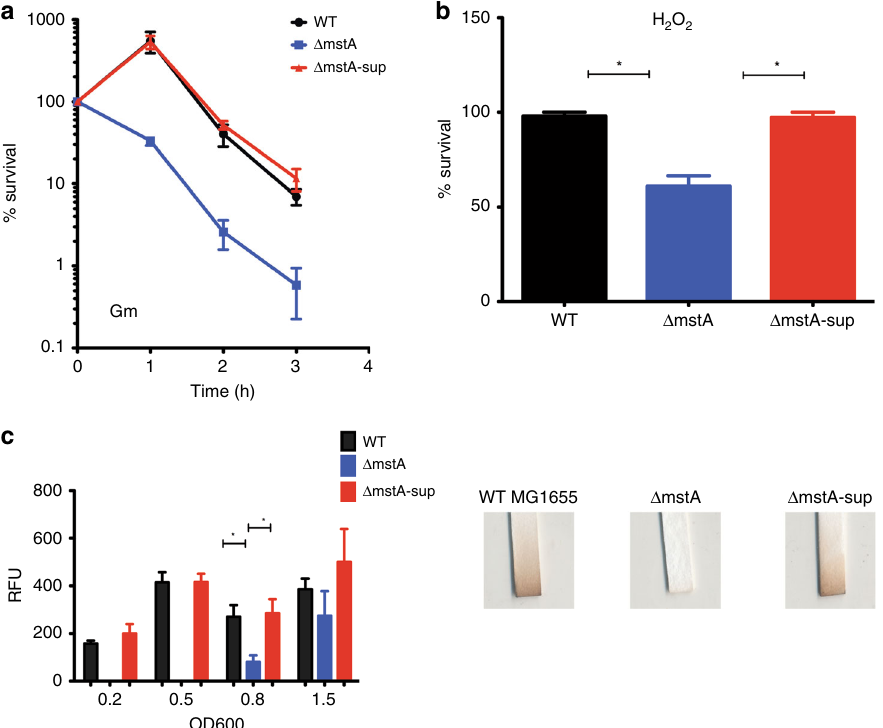
Fig. 1 E. coli MG1655 lacking 3MSTA acquires phenotypic suppression and has increased H 2 S levels and tolerance to Gm and H 2 O 2 . a Δ mstA-sup has increased survival rate compared with Δ mstA when treated with 2 µ g ml − 1 gentamicin in a time-kill assay. Values correspond to colony-forming units (c.f.u). b Δ mstA-sup also has increased tolerance after exposure to 5 mM H 2 O 2 for 30 min. c H 2 S production as measured with fl uorescent probe, WSP5. Relative fl uorescent units are normalized to OD 600 and minus the background fl uorescent of PBS buffer + 100 µ M L-cysteine and WSP5. H 2 S reacts with lead acetate, leading to staining of strips (Sigma-Aldrich). Values are means ± SD ( n = 3). * p < 0.05 as determined by the Student's t test. Source data